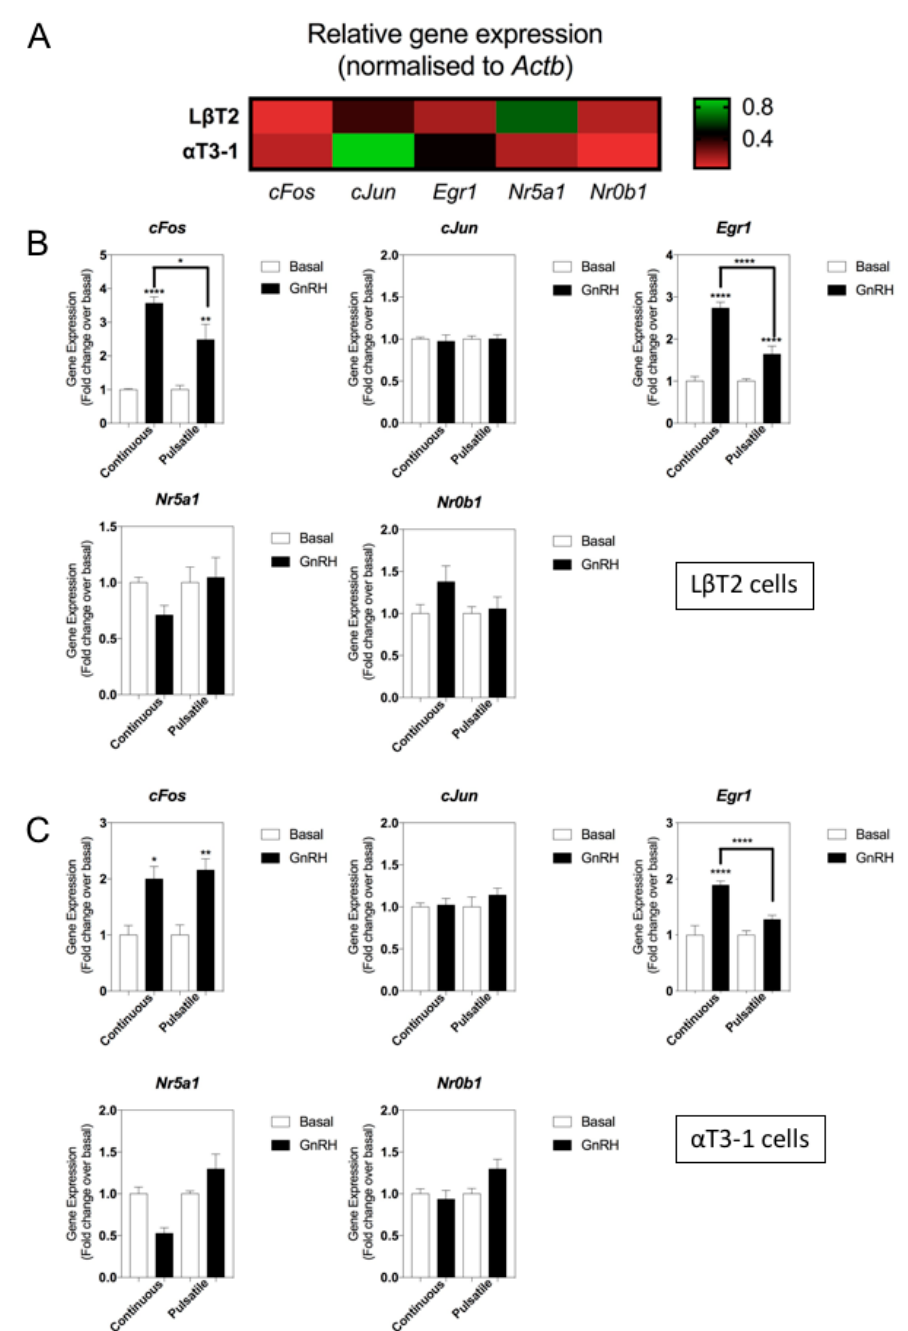
Figure 4. Effect of continuous or pulsatile GnRH stimulation on gonadotrope transcription factor gene expression in L β T2 and α T3-1 cell lines. ( A ) Comparison of gonadotrope transcription factor expression ( cFos , cJun , Egr1 , Nr5a1 , Nr0b1 ) in L β T2 and α T3-1 cells. Data shown are means (n = 5 to 8 individual RNA extractions) of relative gene expression (normalized to ActB ; red indicates low level expression, green indicates high level expression. ( B , C ) L β T2 cells ( B ) or α T3-1 cells ( C ) were treated with 0 or 100 nM GnRH, for either 4 h continuously, or as 5 min pulses every hour for 4 h, before extracting RNA and performing multiplex RT-qPCR for gonadotrope transcription factors. Data shown are means ± SEM (n = 6 to 9 individual RNA extractions) of relative gene expression (normalized to ActB ); *** p < 0.001, ** p < 0.01, * p < 0.05, significantly different from basal, or continuous vs pulsatile, as indicated).